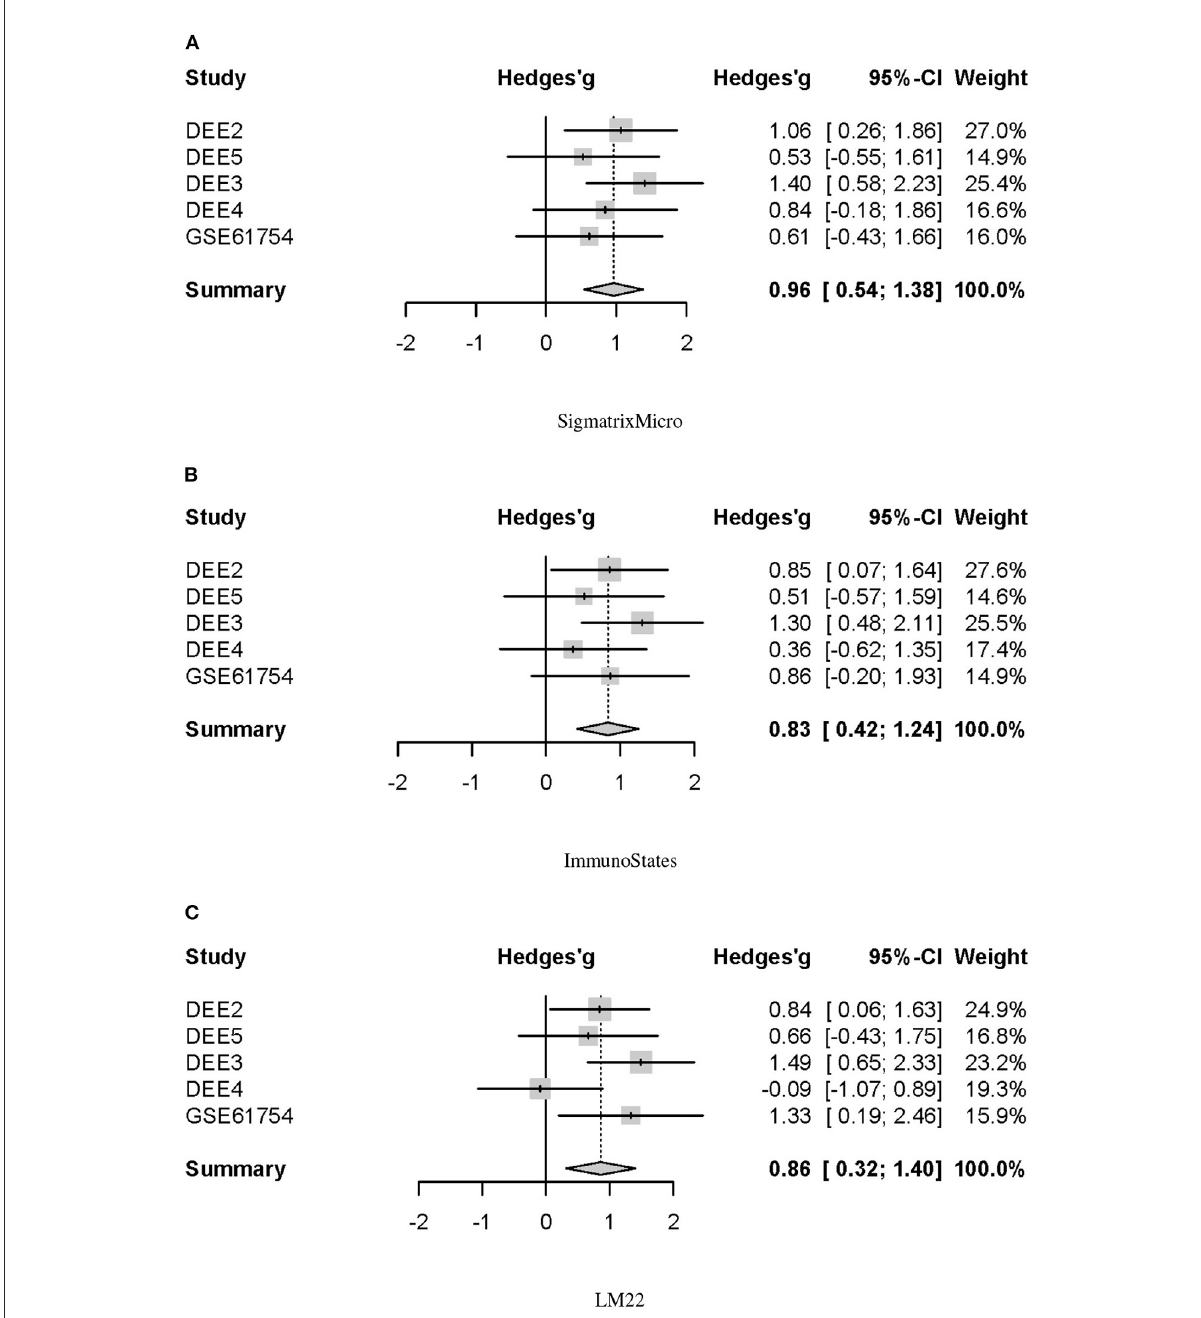
FIGURE5 Forest plot for the baseline NLR differences between SI and AU groups in five challenge cohorts. (A) SigmatrixMicro. (B) ImmunoStates. (C) LM22.